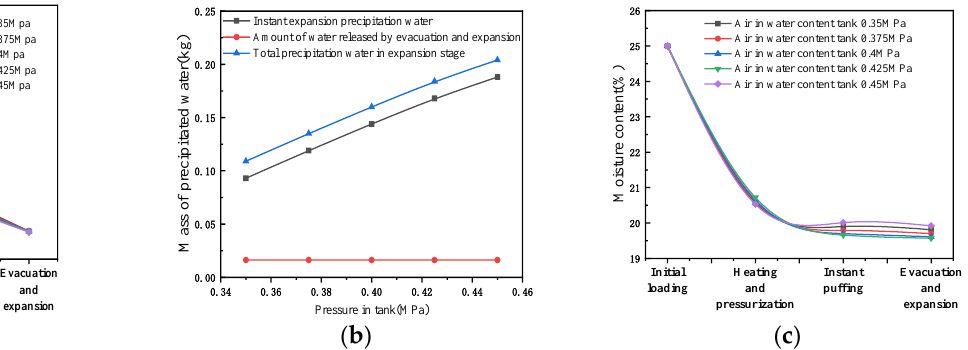
Figure 5. Effect of temperature in tank on mass transfer in expansion stage. ( a ) Effect of the tem- perature in the pressure section on the drying temperature of expanded fruit. ( b ) Influence of temperature in pressurized section on water precipitation in expanded section. ( c ) Effect of tem- perature in pressurized tank on moisture content of dried fruit.